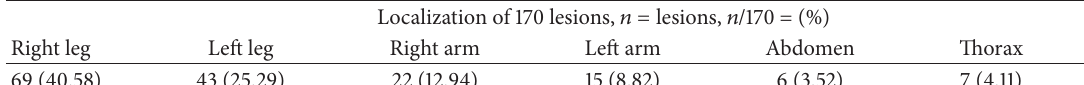
Table 1: Lesions in patients with primary infection and their treatment. (a) Localization of 170 lesions, 𝑛 = lesions, 𝑛 /170 = (%)